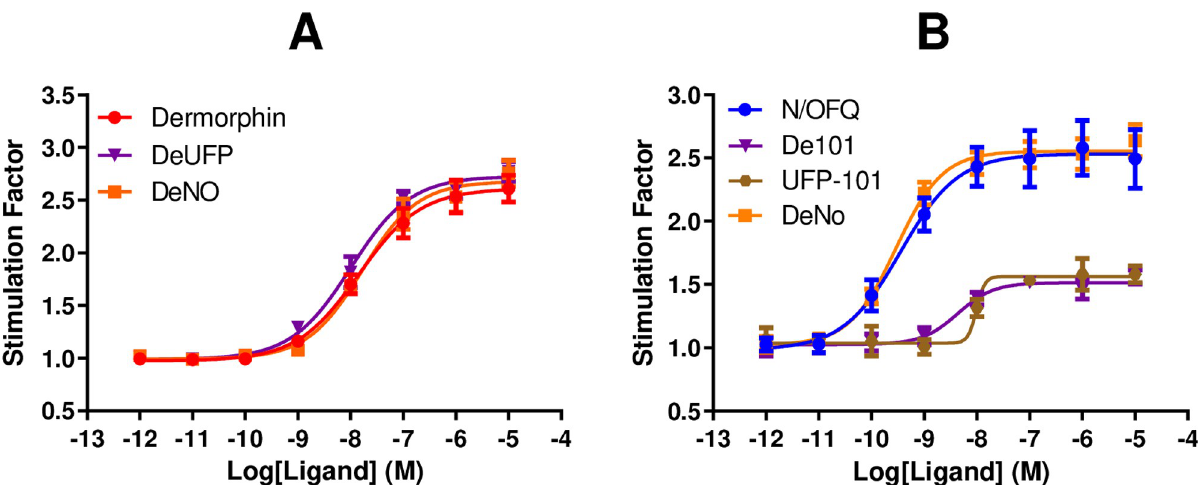
Fig 2. A) Ligand stimulated GTP γ [ 35 S] binding by Dermorphin and De101 are shown in CHO MOP cell membranes. B) Ligand stimulated GTP γ [ 35 S] binding by N/OFQ, UFP-101 and De101 are shown in CHO NOP cell membranes. DeNO curves are replicated from previous studies [14]. Data are